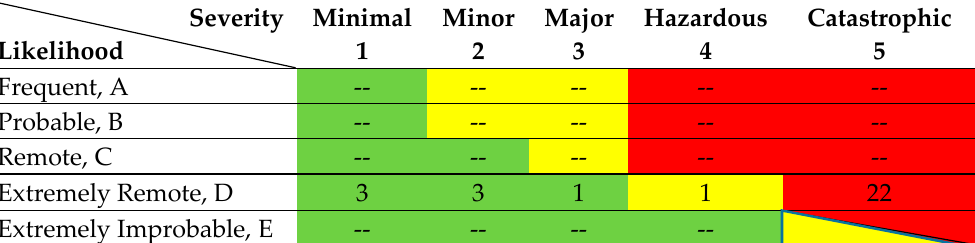
Table 11. Risk matrix with look-ahead time 180 s, head-to-head scenario.